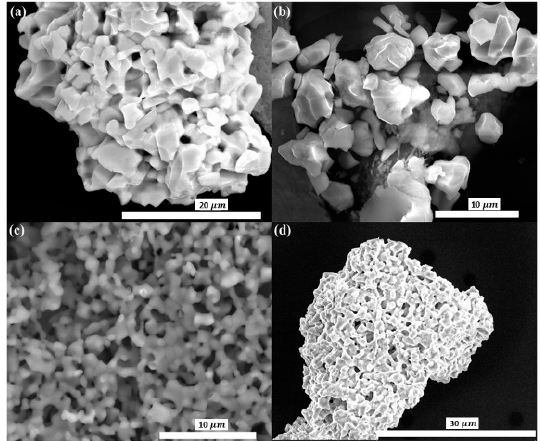
Figure 3. SEM images of the as-synthesized Li 2 SnO 3 samples. ( a ) S1 ( b ) S2 ( c ) S3 ( d ) S4.